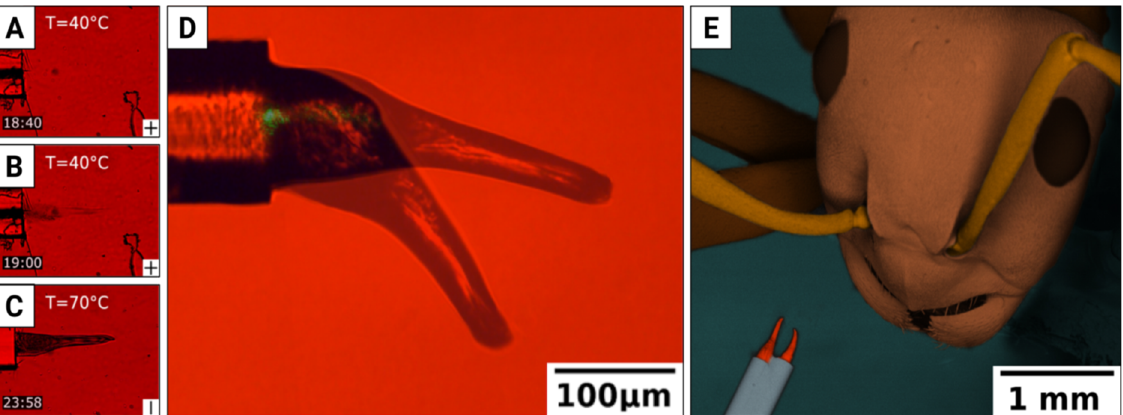
Figure 8. Fiber-grown microscale gripper. ( A – C ) Snapshots from the video show the bending actuator growth inside an LC-mixture-filled cell. Time in min: sec is shown in the bottom left corner of each frame. ( D ) Bending actuator in action, powered with green light delivered through the fiber (two photographs have been superimposed to show the magnitude of the deformation). ( E ) Two fibers with bending actuators make a light-powered gripper, here next to a Formica polyctena ant with its mandibles about ten times the size of our tool. Adapted from [93].